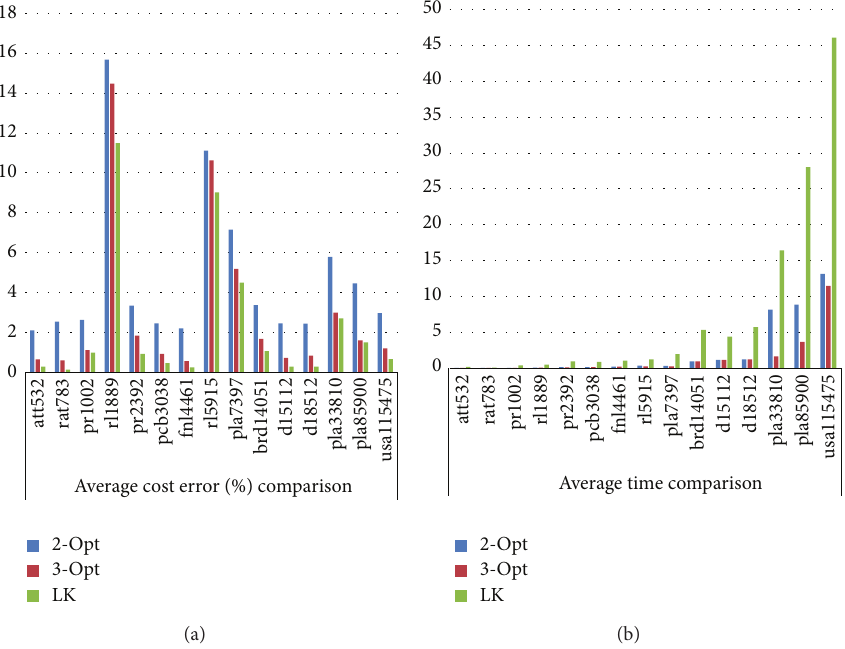
Figure 5: (a) Average cost error percent. (b) Average of twenty runtimes of each